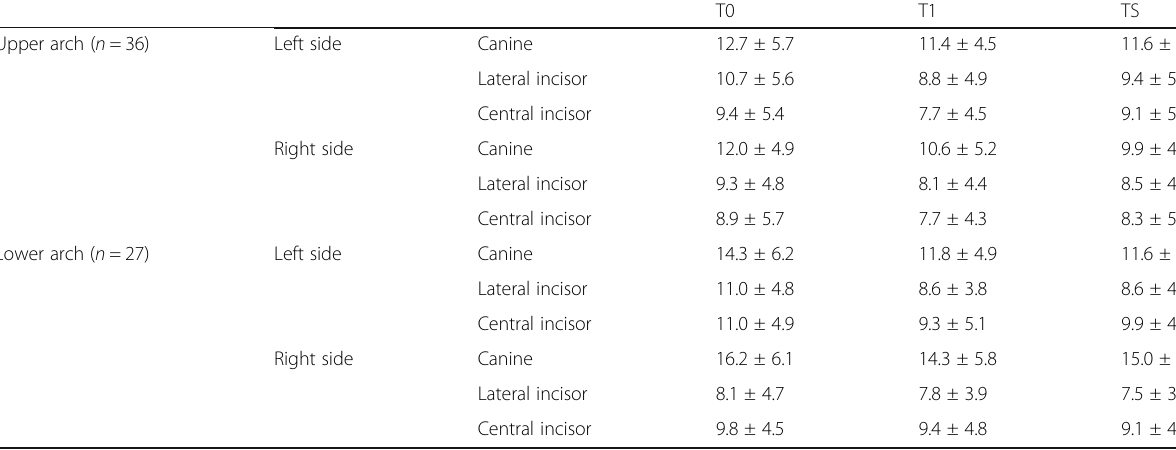
Table 2 Descriptive statistics for torque